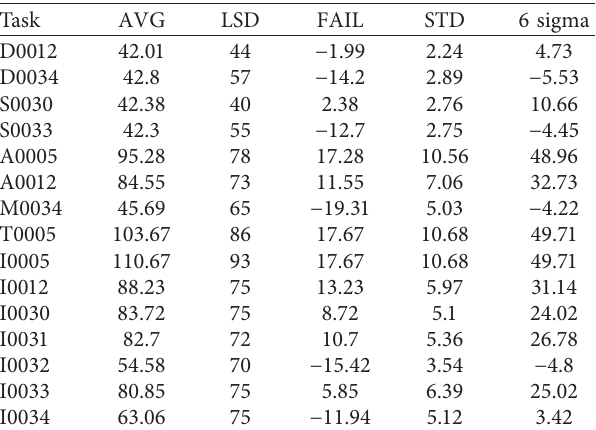
Figure 12: ESD comparison. Table 6: Reliability data.